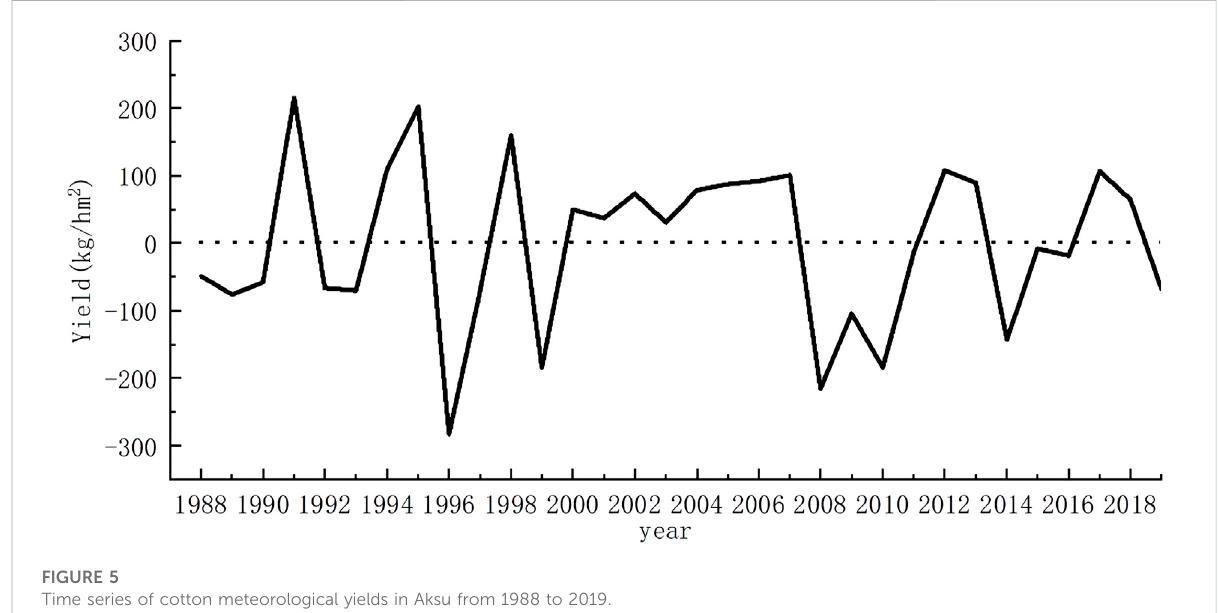
FIGURE 5 Time series of cotton meteorological yields in Aksu from 1988 to 2019.